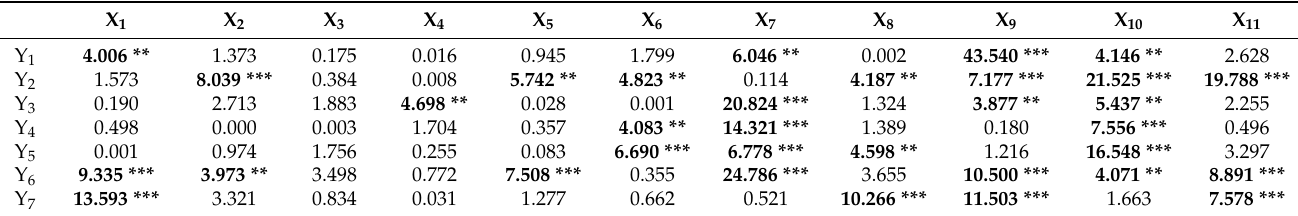
Table 4. Bivariate correlation results between reported outage impacts and select household